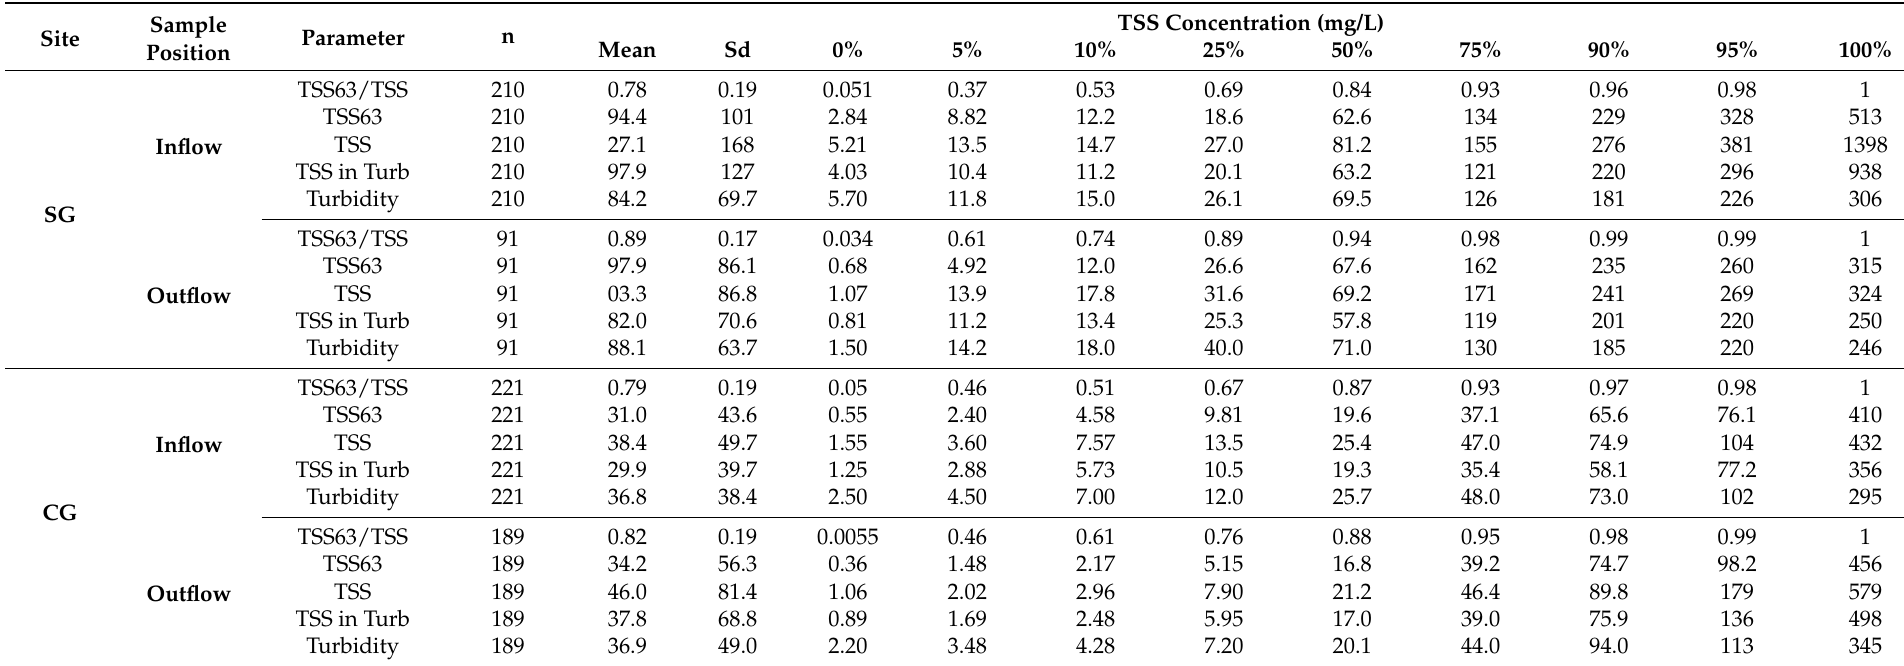
Table A2. Descriptive statistics of TSS concentration, TSS63-ratio, and turbidity from bottle samples per site and sample position, with TSS values in mg/L and turbidity in FNU. Samples were taken from January 2018 until July